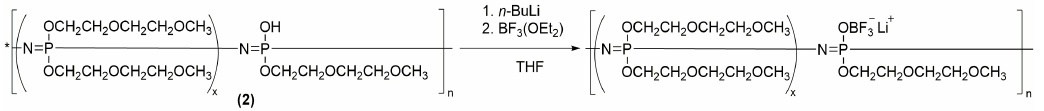
Figure 2. Last step of the synthesis of poly[bis 2(2-methoxyethoxy)ethoxy-co-oxytrifluoroborat lithium phosphazene].